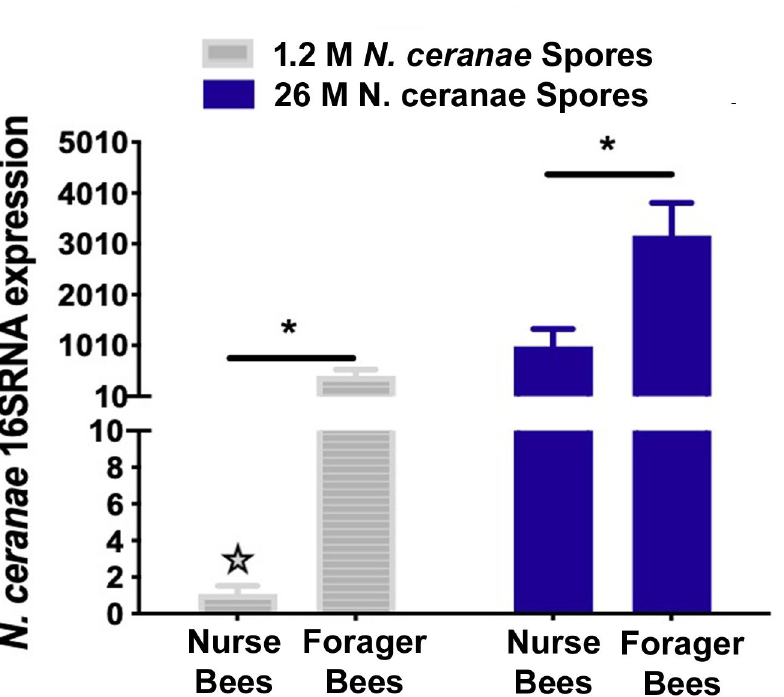
Fig 3. Expression levels of N . ceranae 16S rRNA. The transcriptional activity of N . ceranae 16S rRNA was corresponding with the level of spore loads in infected bees. The relative expression of N . ceranae 16S rRNA in forager bees was significantly higher than in nurse bees under both high- and low- levels of infection (1.2 M vs 26 M N . ceranae spores per bee). The relative expression was expressed as an n-fold difference relative to the calibrator (marked by a star) by 2 – ΔΔ Ct method. A star denotes a calibrator and an asterisk ( � ) denotes a statistically significant difference between the two groups ( P � 0.05, Student’s